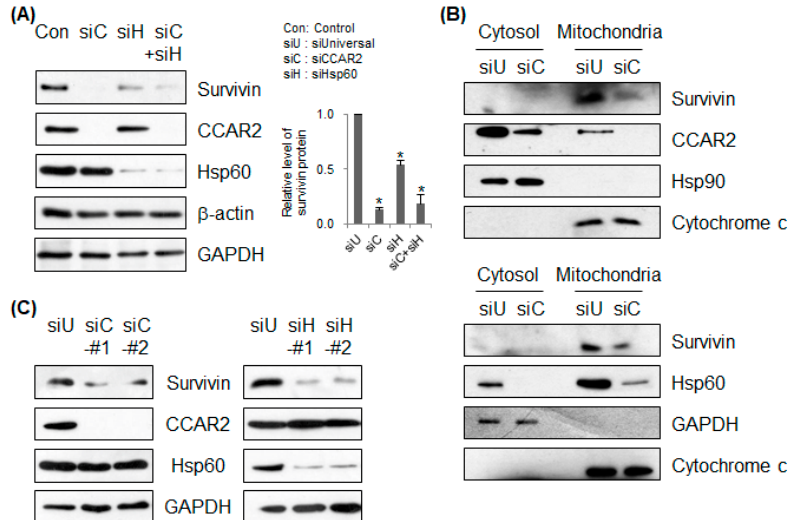
Figure 2. Deficiency in CCAR2 or Hsp60 reduces expression of survivin. SH-SY5Y cells were transfected with Universal (siU), CCAR2 (siC), or Hsp60 (siH) siRNA. Forty-eight hours later, expression of survivin protein was examined by western blotting. ( A ) Survivin expression was detected in whole cell lysates. The relative level of survivin protein is presented as the mean ± standard error of the mean (SEM) ( n = 3). Asterisks (*) denote statistically significant differences ( p < 0.05, one-way ANOVA). ( B ) Cytosolic and mitochondrial fractions were isolated to determine localization and expression of survivin. ( C ) Two different siRNAs specific for CCAR2 and Hsp60 were used to knock down their expressions.